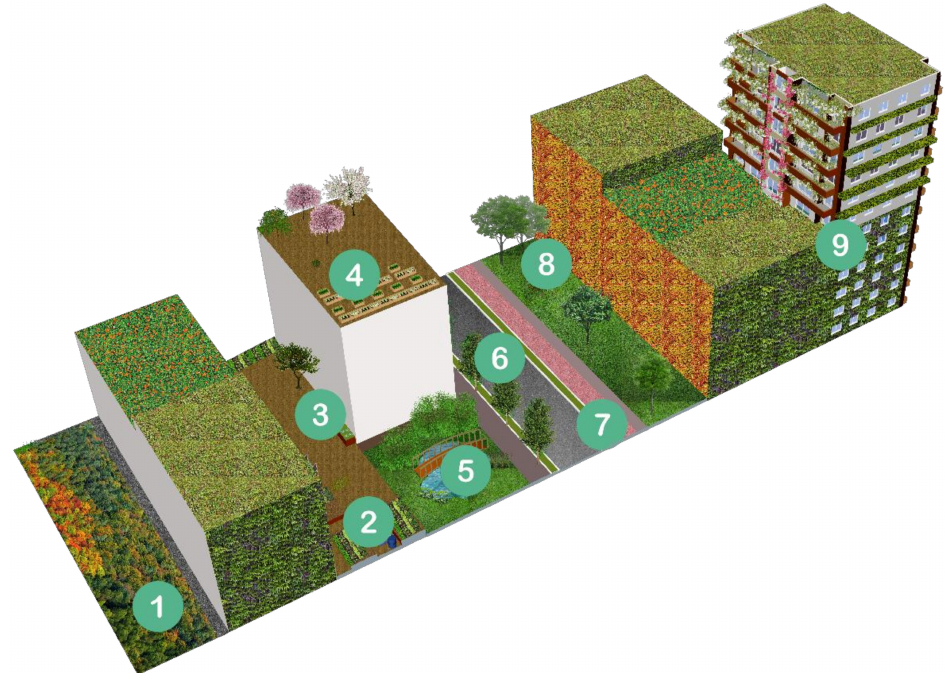
Figure 4. Landscape architectural designs and features of compact cities, promoting ecosystem services, biodiversity, mental health and wellbeing, include: ( 1 ) urban forest/urban parks, ( 2 ) allotment gardens, ( 3 ) vegetable raingardens, ( 4 ) edible green roofs, ( 5 ) detention and retention ponds/wildlife ponds, ( 6 ) street trees, ( 7 ) bioswales, ( 8 ) domestic/rain gardens, ( 9 ) building integrated vegetation (e.g., biodiverse green roofs, green walls and climbing plants).